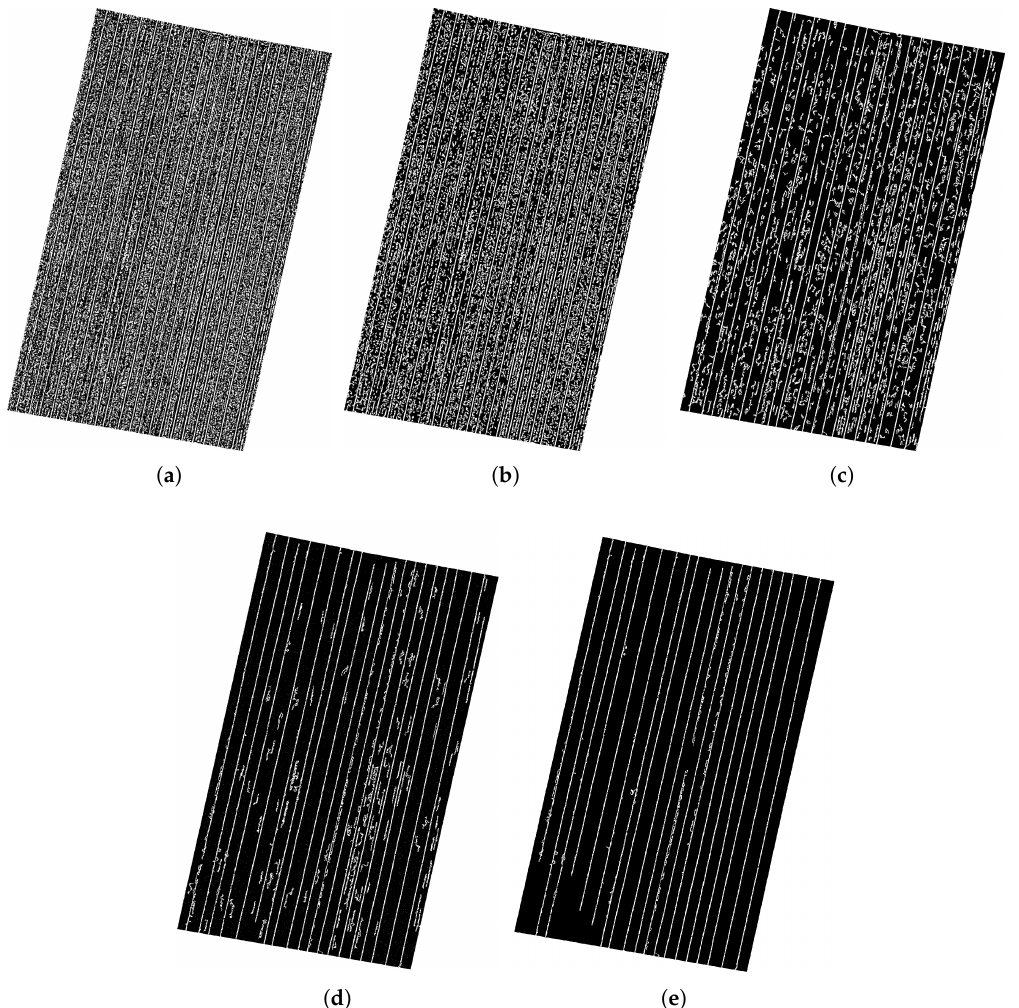
Figure 9. Extracted results using the shape index filter. Ridge candidates are valued as 1 in white and non-ridge candidates are valued as 0 in black. ( a ) binary image ( f 1 ) as S 0 segmented from surface roughness of Plot 1, ( b ) result ( S 1 ) after the first filtering using mean area of S 0 , ( c ) result ( S 2 ) after the second filtering using mean MER perimeter of S 1 , ( d ) result ( S 3 ) after the third filtering using mean major axis length of S 2 , ( e ) result ( S 4 ) after the fourth filtering using MER area of S 3